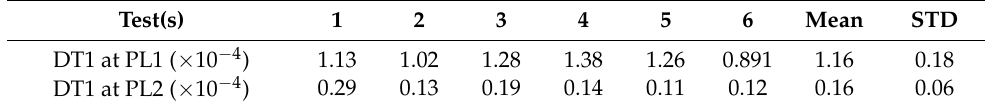
Table 5. Normalized pressure amplitudes of RVR at DT1 sensor for PL1 and